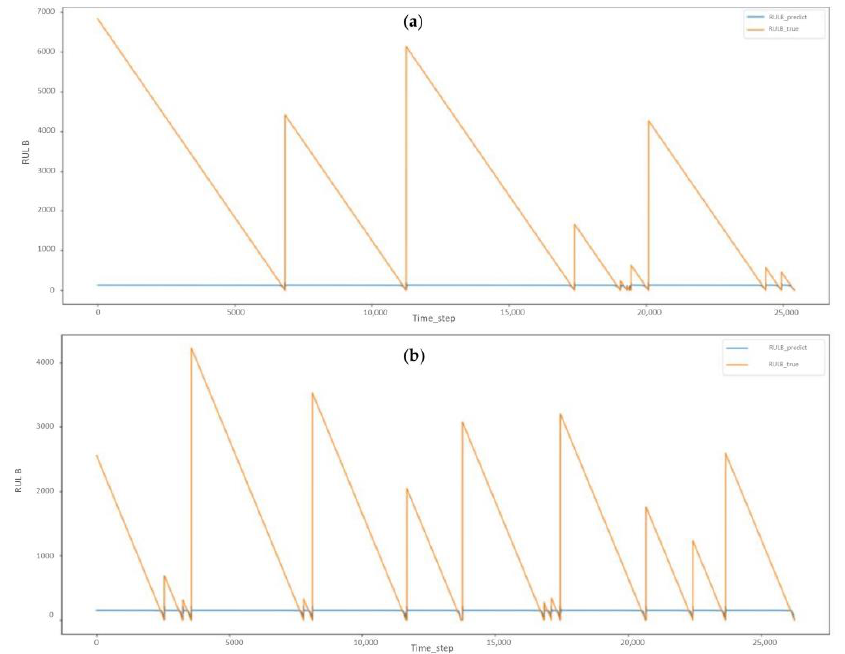
Figure 14. ( a ) LSTM method for discrete-RULB cluster 2; ( b ) LSTM Method for discrete-RULB cluster